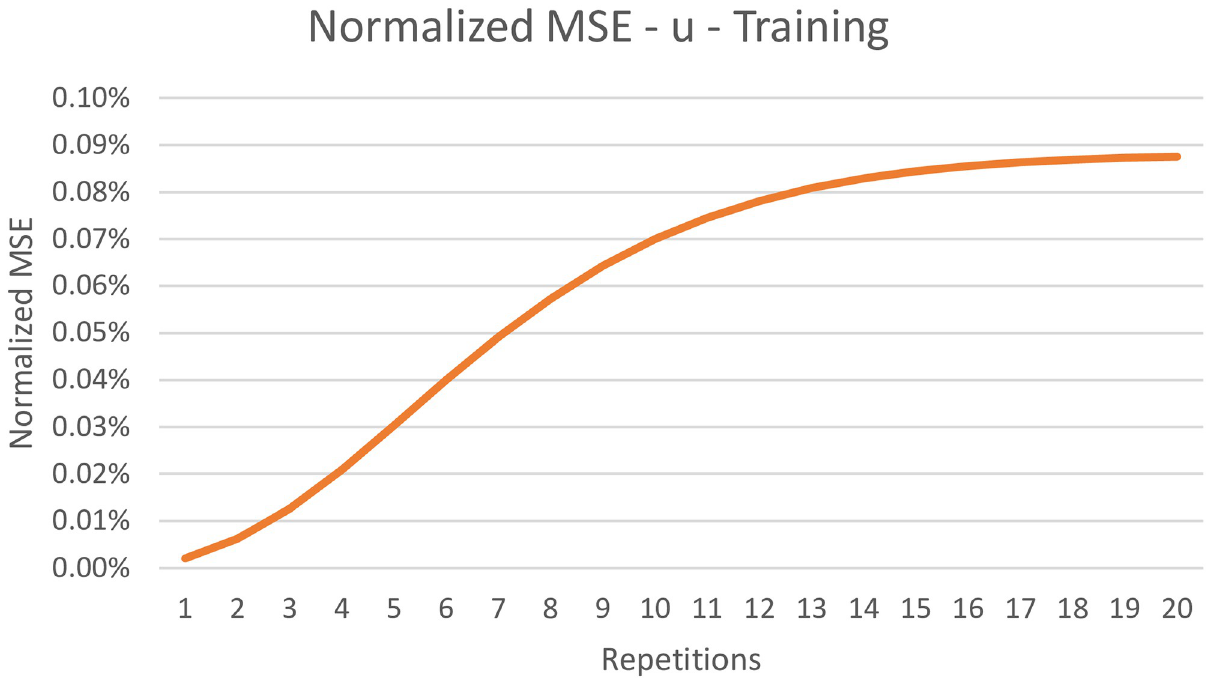
Fig 3. Normalized RMSE of motor command during training. Normalized root mean-square error (RMSE) in motor command output of TorchDIVA vs DIVA over 20 repetitions during the training process with the speech target ‘u’.